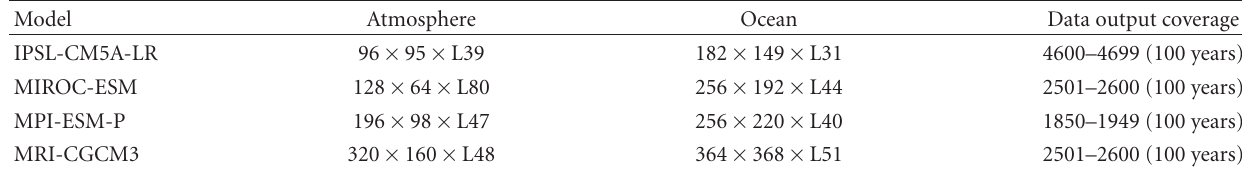
Table 1: PMIP3 LGM models.